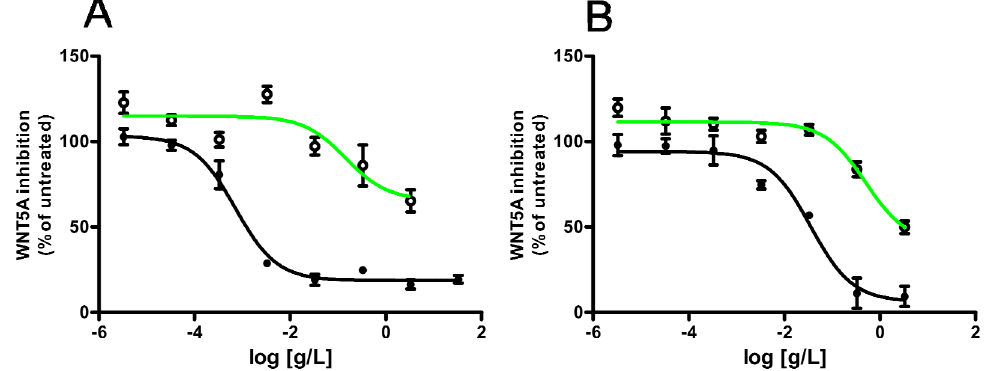
Figure 7. In vitro simulated GI digestion reduces WNT inhibitory activity of AAE and LAE. Dose-response curves for AAE ( A ) and LAE. ( B ) Modulation of the WNT/ β -catenin pathway before (black lines) or after in vitro simulated GI digestion (green lines). Values are reported as mean ± SD ( n = 3).